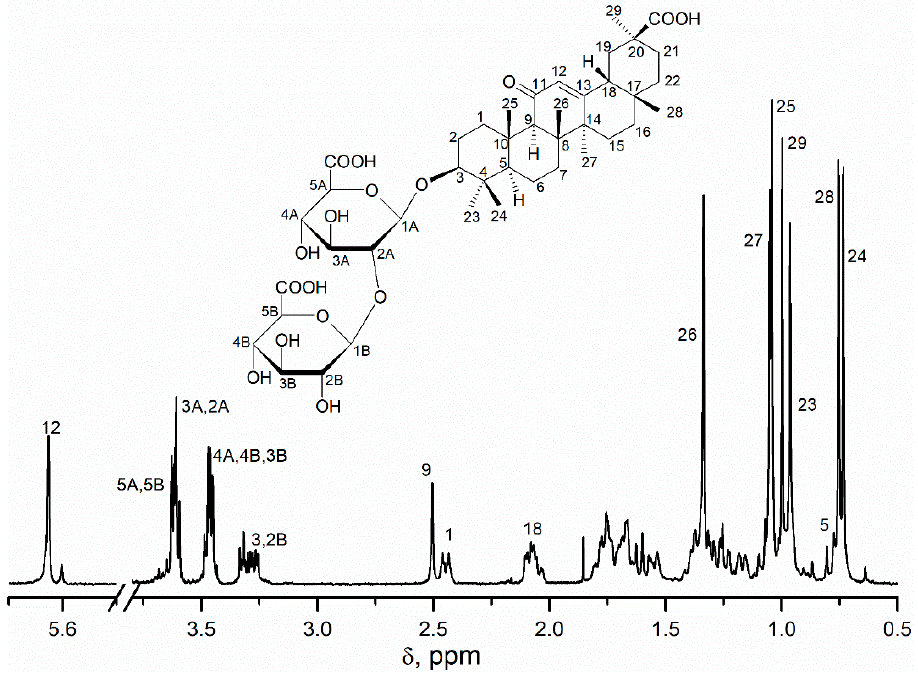
Figure 1. The structure and 1 H NMR spectrum (500 MHz) of GL in D 2 O at pH = 7.2.